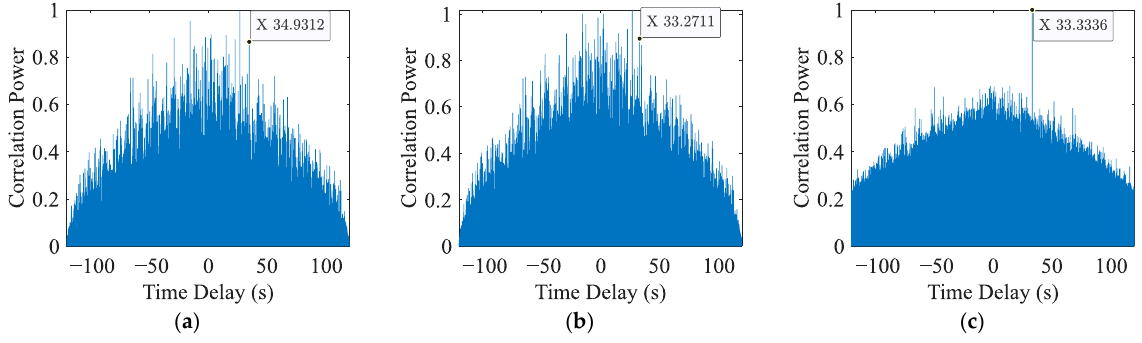
Figure 3. Correlation results of the three different methods in − 40 dB. ( a ) Correlation results of GCC- PHAT after normalization in − 40 dB, ( b ) correlation results of CC after normalization in − 40 dB, and ( c ) correlation results of our method in − 40 dB. Table 2. Time delay errors in low SNR.